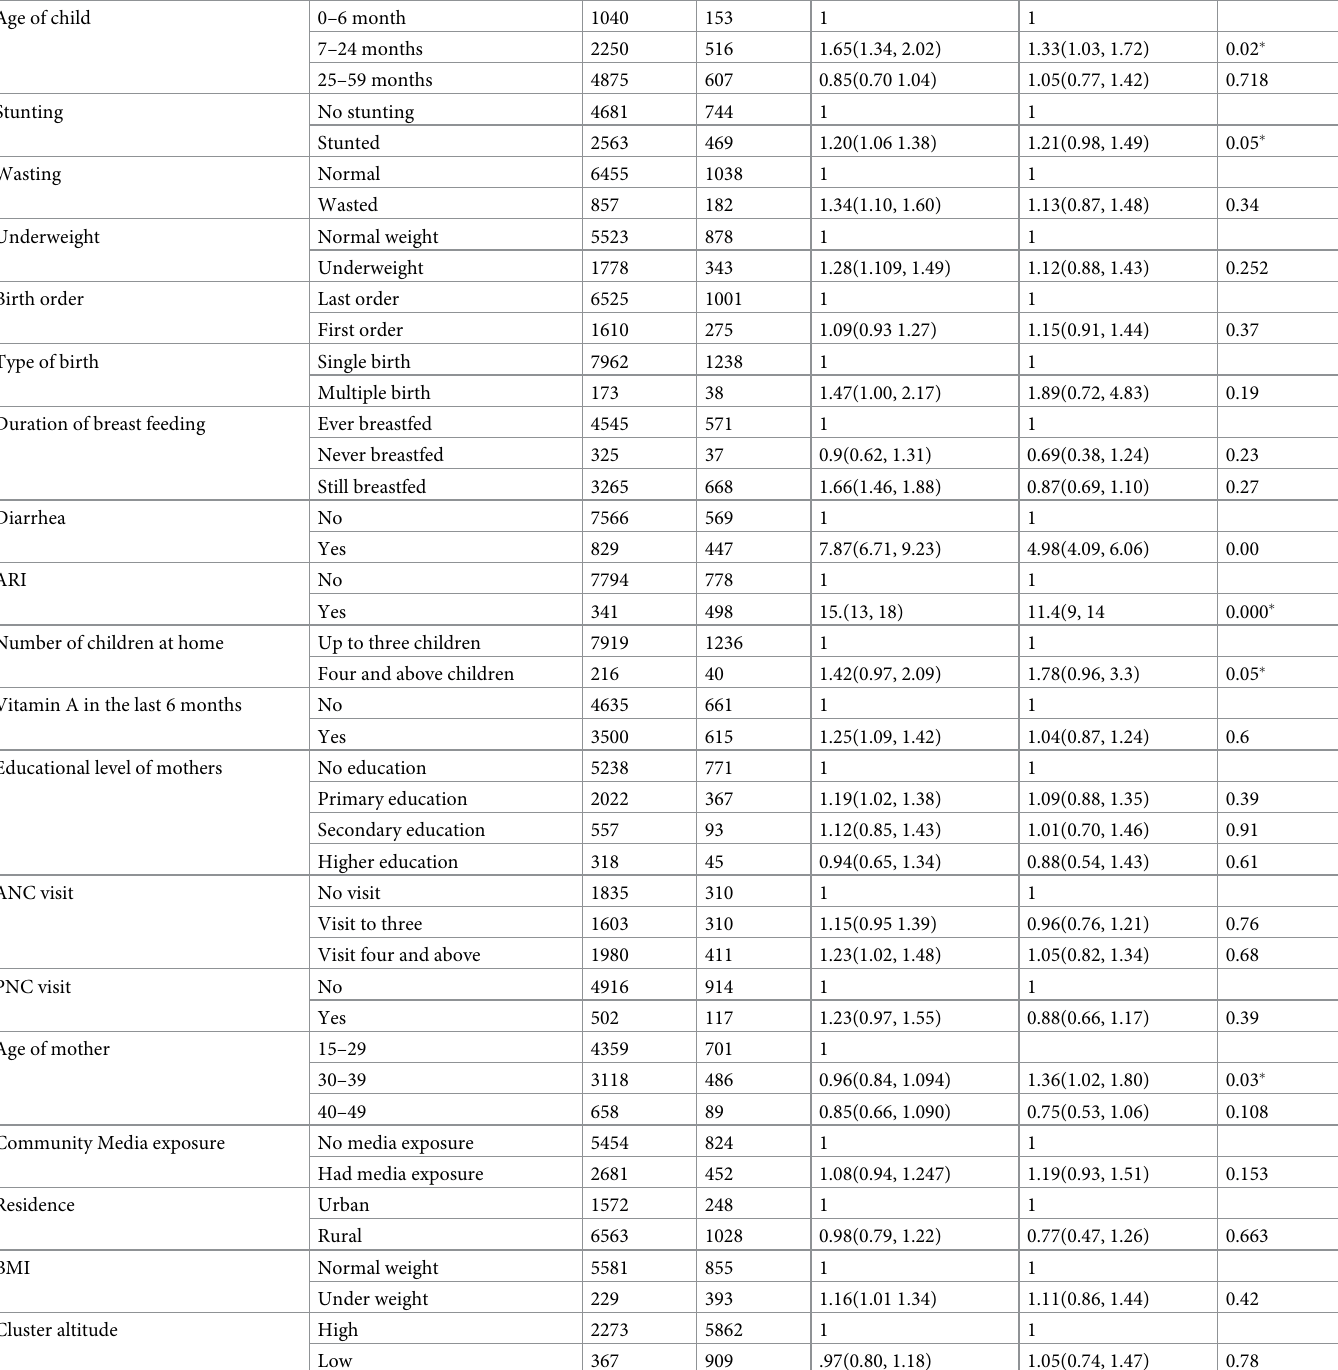
Table 2. Bi variable and multi variable multilevel log-binomial regression for childhood febrile illness Ethiopia 2016(final model). Age of